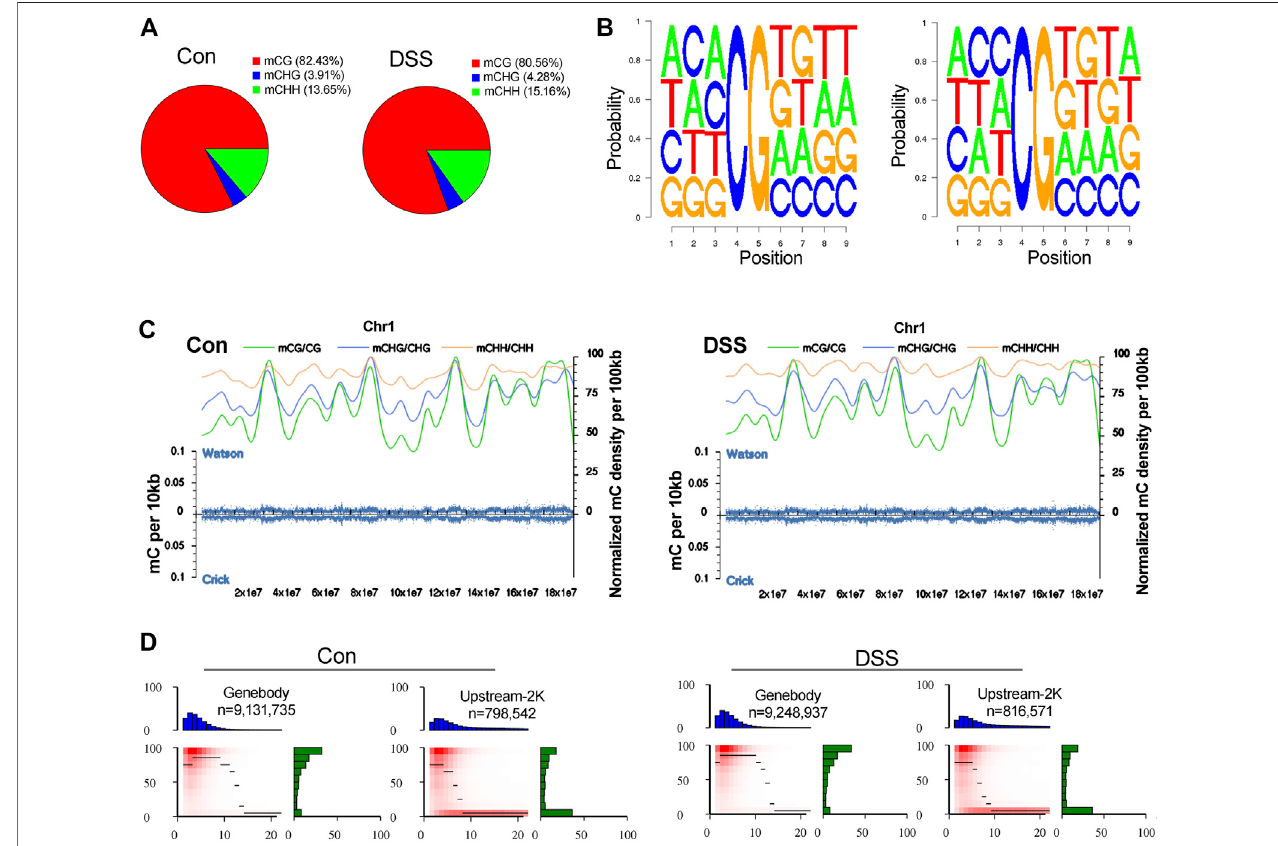
FIGURE4| Theimpactofchronicin fl ammationupontheDNAmethylationpro fi leincolonmucosa. (A) TheratioofdifferenttypesofmC(mCG,mCHG,andmCHH) in dextran sulfate sodium (DSS)-treated and control mice were assessed, in which mCG was 82.43 and 80.56% in control and DSS-treated mice, respectively. (B) The sequencecharacterizationofthenucleotidesnearmethylationCofCG,bycountingthe9-bpbasenearCGbasesandcomparingthebaseofCGandmCGinthewhole genome. (C) mC density in control and DSS-treated mice chromosome 1. (D) The characteristics ofmethylation patterns in different gene regions are represented by heat map.